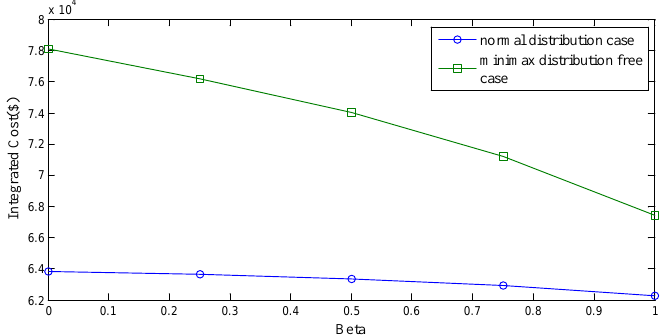
Fig. 1. Integrated cost under normal distribution case and minimax distribution free case with different